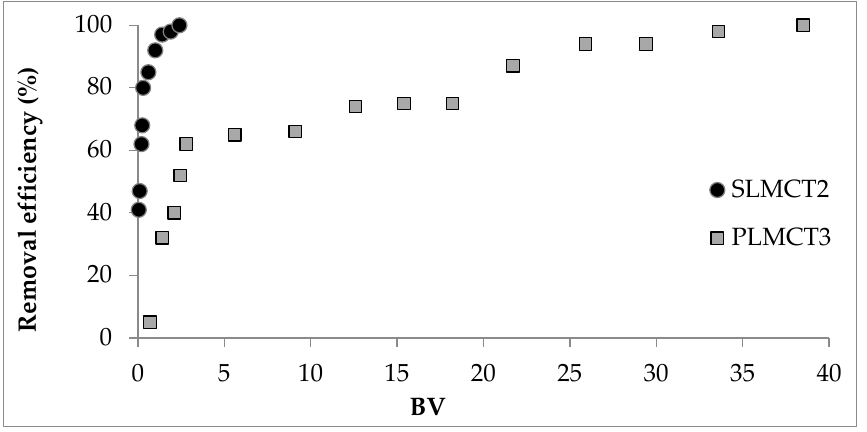
Figure 10. Phosphate adsorption in continuous mode onto composites SLMCT 2 and PLMCT 3 materials. Values obtained at C i : 10 mg · L − 1 PO4 3 − , PLMCT 3 w: 10 ± 0.3 g and SLMCT 2 w: 10 ± 0.2 g.